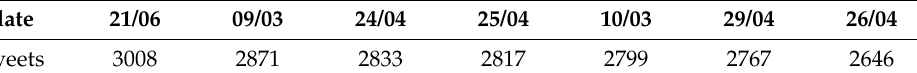
Table 8. Lowest game-related tweeting per day.